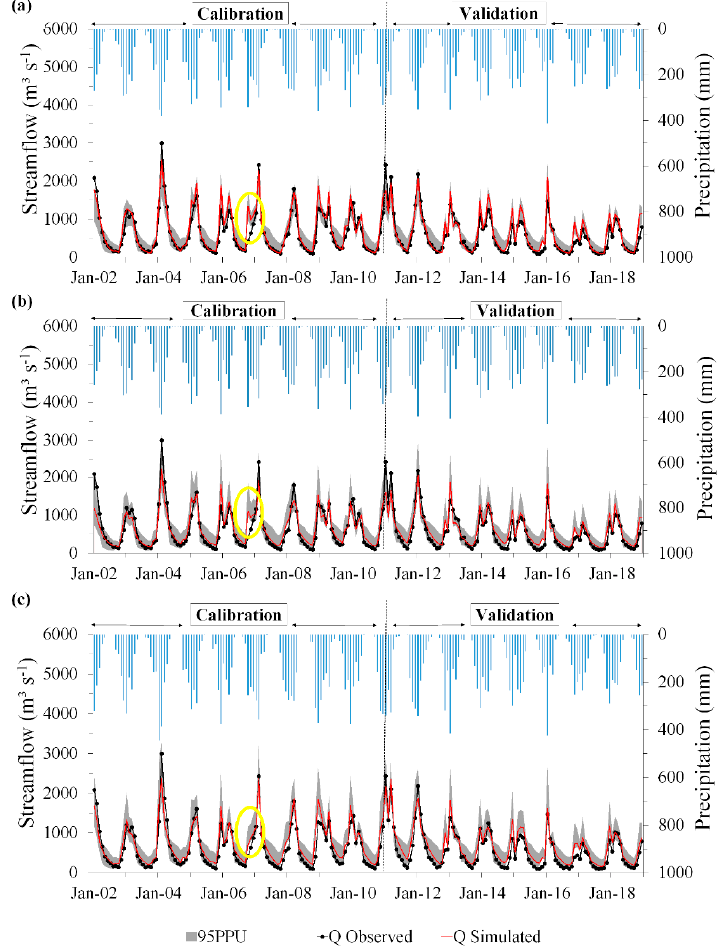
Figure 6. Observed 95% prediction uncertainty (95PPU) and simulated monthly streamflow driven by ( a ) TMPA, ( b ) IMERG, and ( c ) rain gauges. The yellow circle represents an anomaly in the simulated streamflow driven by SPPs.